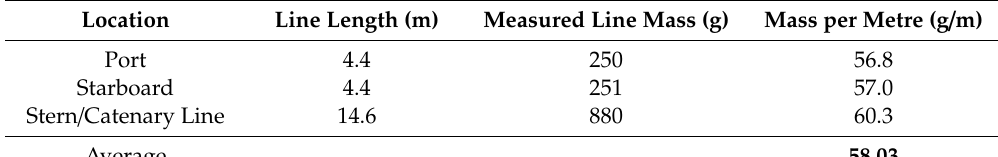
Figure 2. Best-fit approximation of the spring constant of the designed mooring lines. Table 1. Scaled Mooring Line